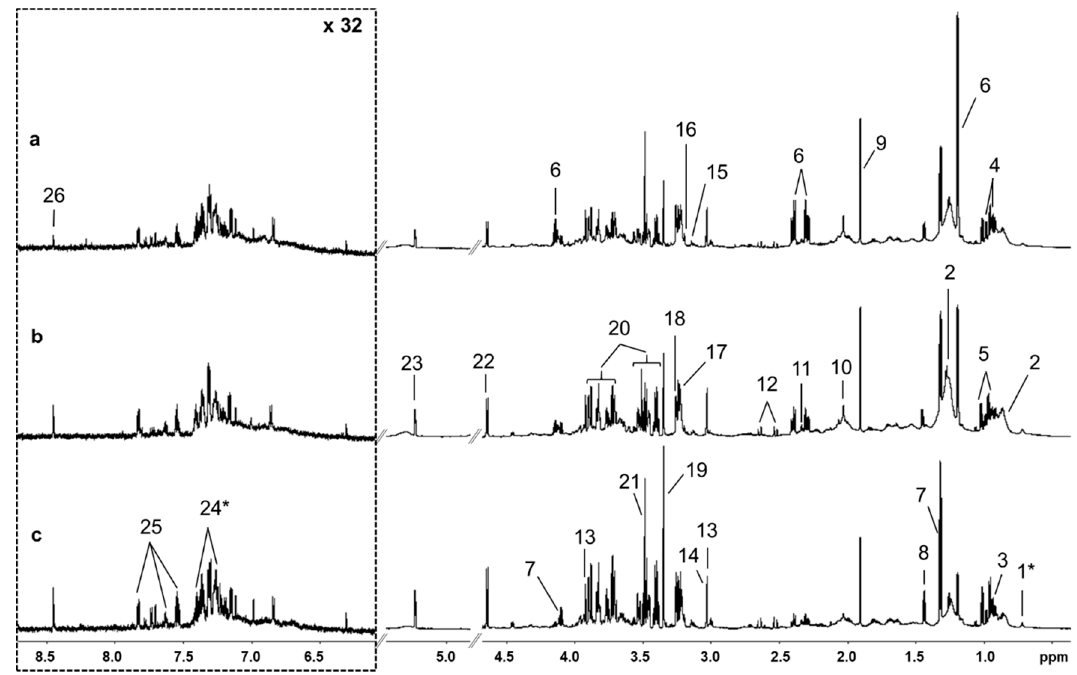
Figure 1. Representative 700 MHz 1 H nuclear magnetic resonance spectra of serum samples from early lactation dairy cows with ( a ) elevated β -hydroxybutyrate (BHBA), ( b ) elevated non-esterified fatty acid (NEFA), and ( c ) normal BHBA and NEFA concentrations. Downfield regions were vertically expanded 32 times for clarity. Legend: 1, cholate; 2, very low density lipoprotein / low density lipoprotein; 3, leucine; 4, isoleucine; 5, valine; 6, β - hydroxybutyrate; 7, lactate; 8, alanine; 9, acetate; 10, N-acetyl glycoprotein; 11, pyruvate;